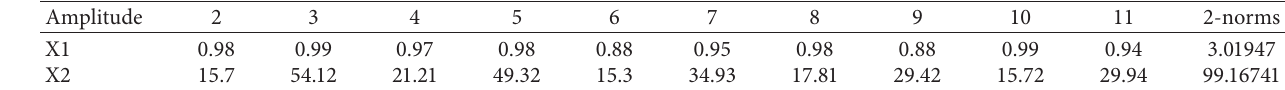
Table 7: Amplitude of kth harmonic content rate of device.